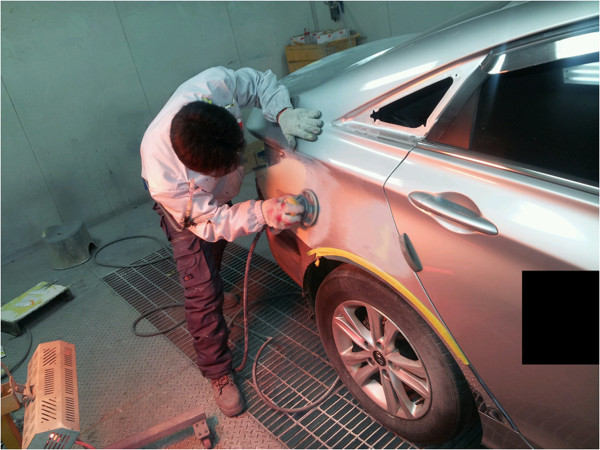
Sanding process.